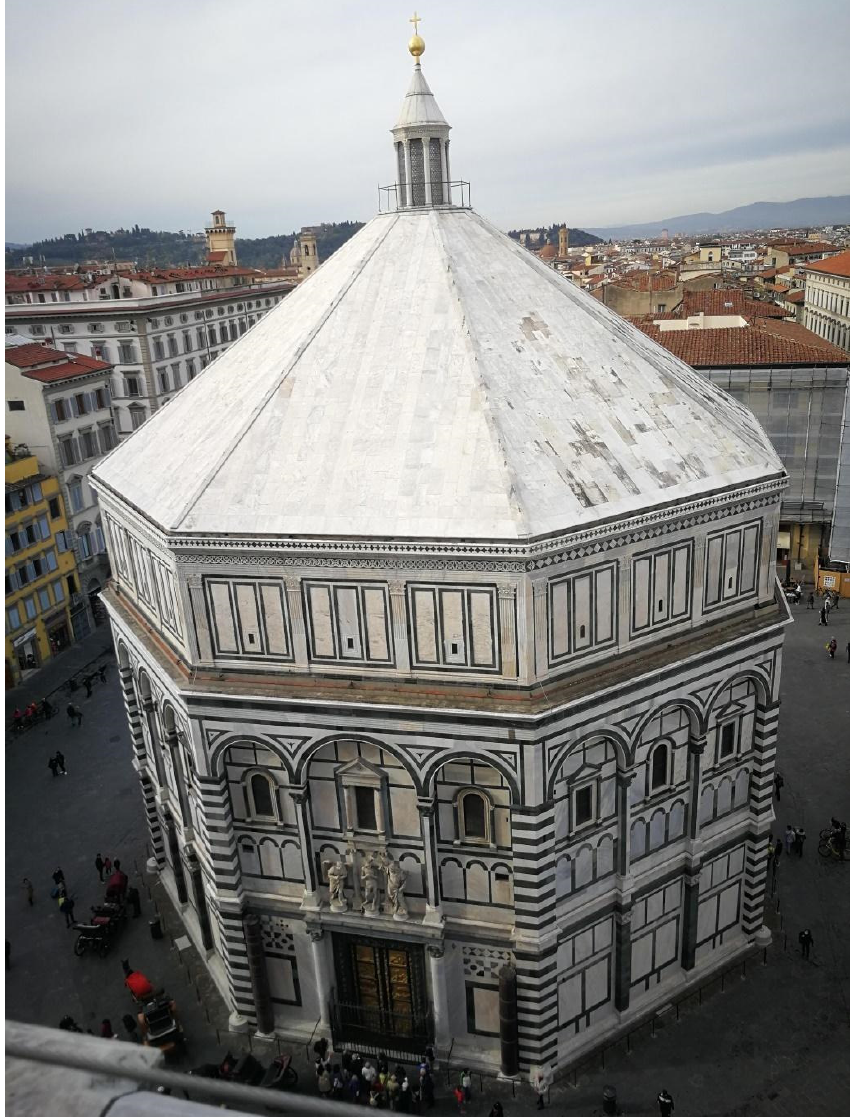
Figure 1. San Giovanni Baptistery in Florence (photo taken from the terrace of the Santa Maria del Fiore Cathedral).